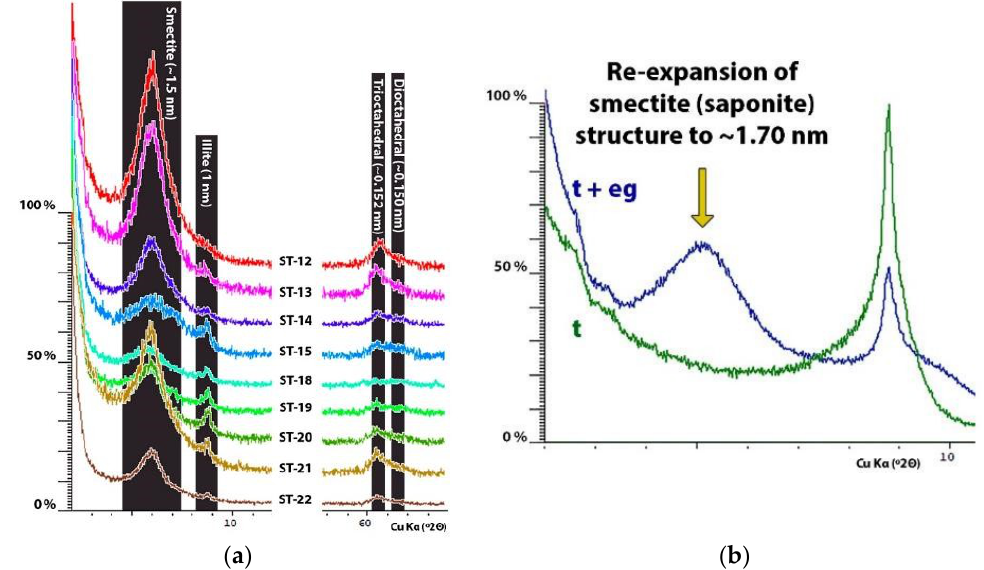
Figure 9. ( a ) XRD patterns of selected clay fraction both oriented mounts (ethylene glycol) and randomly oriented showing the d (060) spacing; and ( b ) test of Christidis and Koutsopoulou [25] on representative smectite-rich sample (BS2II-1).